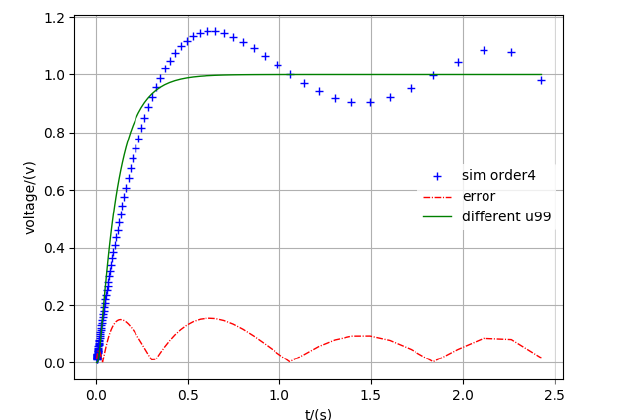
Figure 5. Simulation